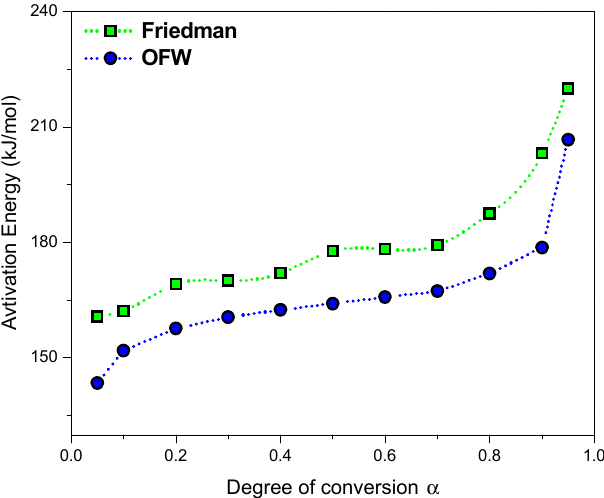
Figure 13. Dependence of the effective activation energy ( E α ) on the degree of conversion ( α ) according to Friedman’s and Ozawa, Flynn, and Wall’s (OFW’s) methods.